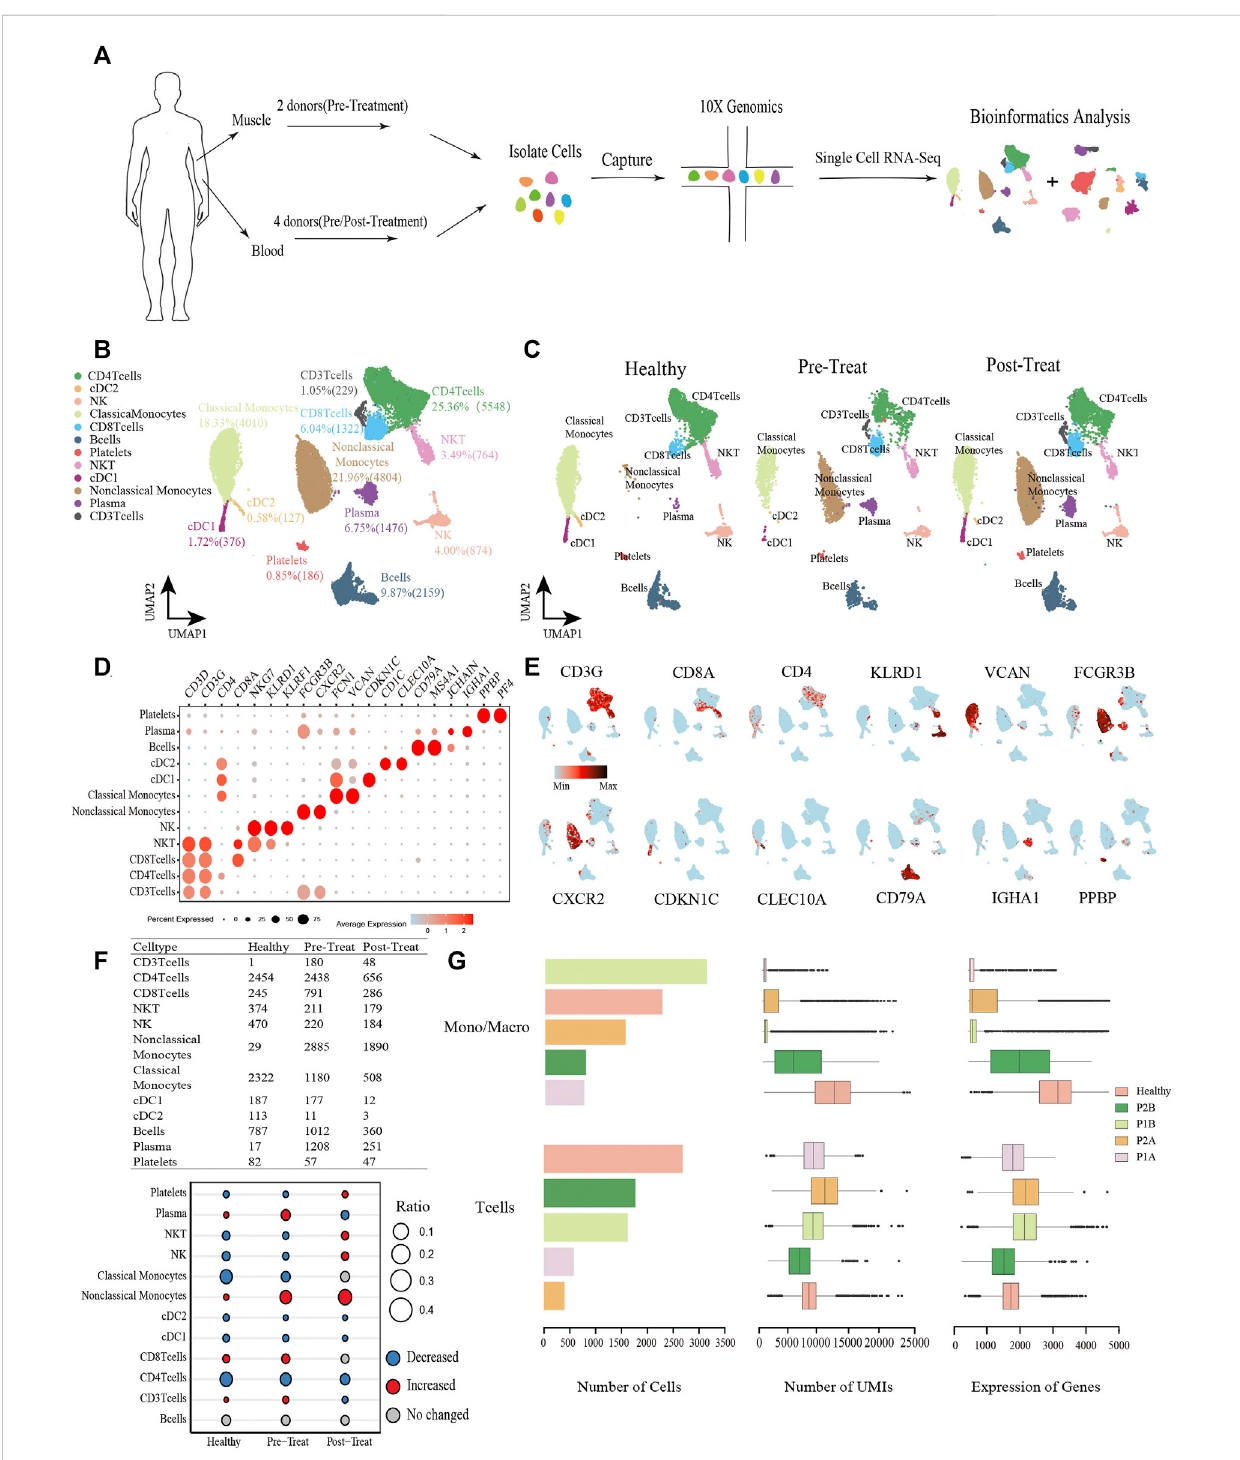
FIGURE 1 Global transcriptomic pro fi les of peripheral blood cells from control and JDM patients reveals their cellular subpopulations as determined by ScRNA-seq. (A) Overall work fl ow for cell sorting andsingle-cell data analyses. (B) Uniform Manifold Approximation andProjection (UMAP)plots of single-cell transcriptomicpro fi les showing cell types of peripheral blood cells from all the samples. Each dot represents a cell, which is colored according to cell type. (C) UMAP plots of single-cell transcriptomicpro fi